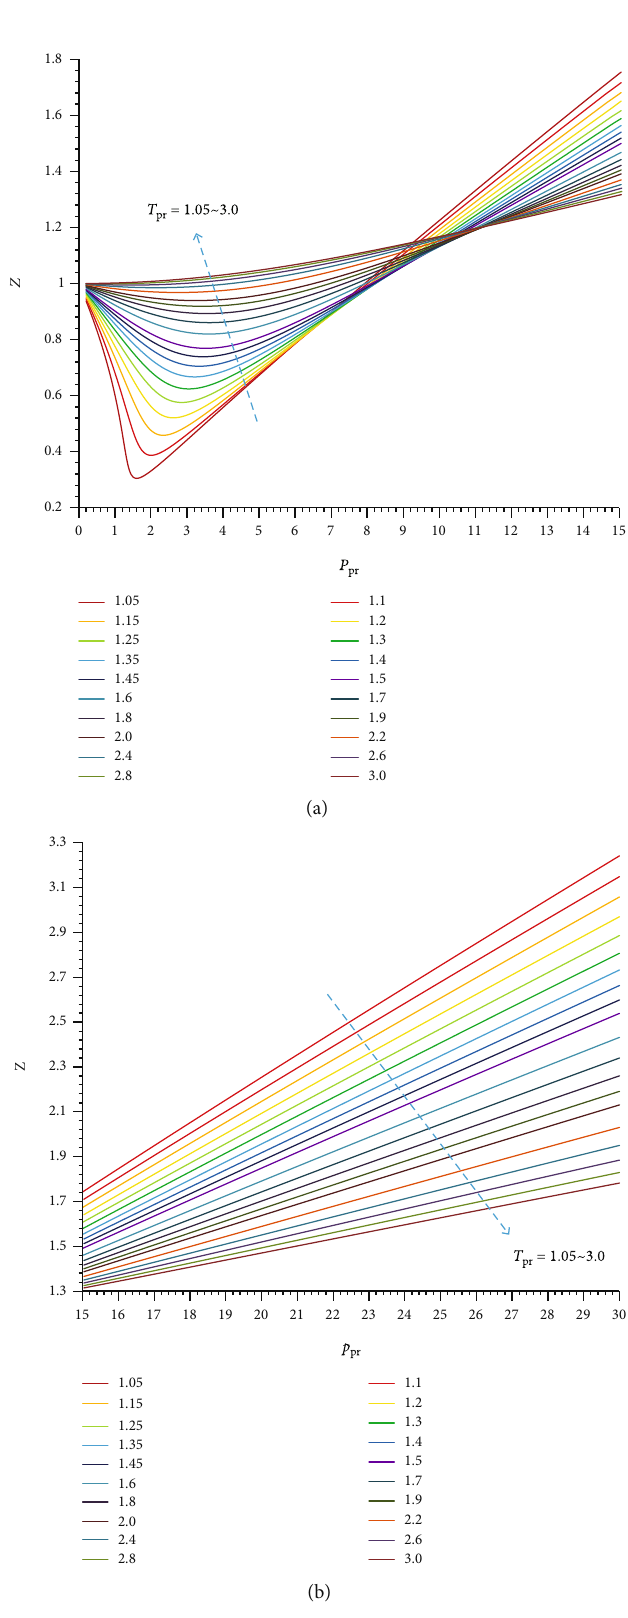
Figure 2: (a) Compressibility factors ( Z -factors) of natural gases obtained by the Hall-Yarborough correlations at pseudoreduced pressures of 0.2 to 15. (b) Compressibility factors ( Z -factors) of natural gases obtained by the Hall-Yarborough correlations at pseudoreduced pressures of 15 to